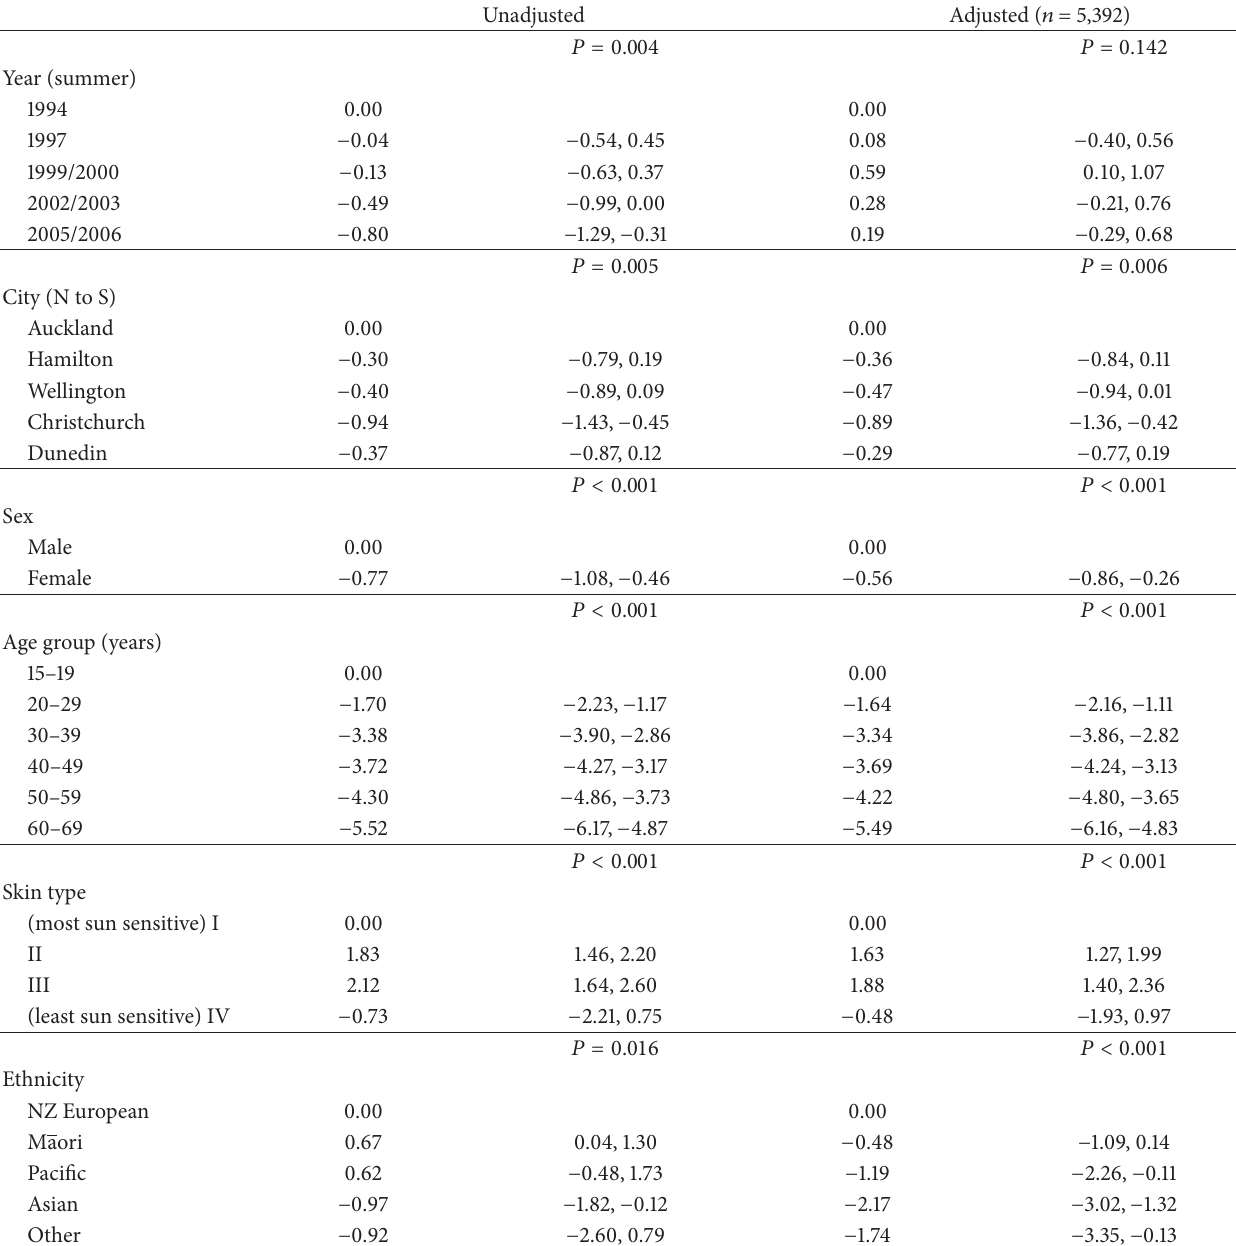
Table 4: Unadjusted and adjusted ∗ effects with 95% confidence intervals for total Protan scores.